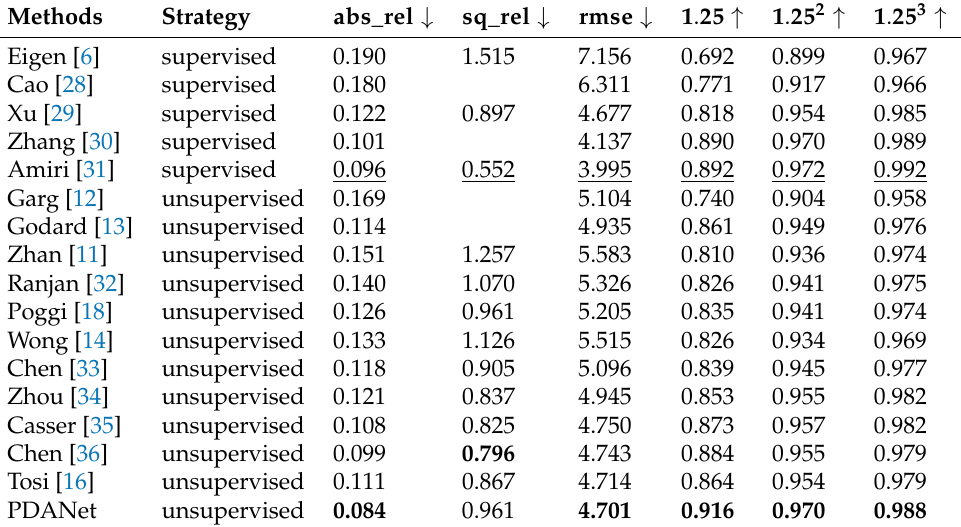
Figure 5. Comparison between PDANet and Monodepth on KITTI 2015 [6]. PDANet achieves much better performance than Monodepth in terms of edges, land marks, and low-texture areas. Table 2. Comparison between PDANet and other models. Best results in supervised methods are in bold, and in unsupervised methods are underlined. For metrics with ↓ the lower the better, for metrics with ↑ the higher the better. All models are tested on KITTI 2015 [6]. Our PDANet outperforms the other models in all metrics; specifically, the abs_rel error is significantly lower than the other models.